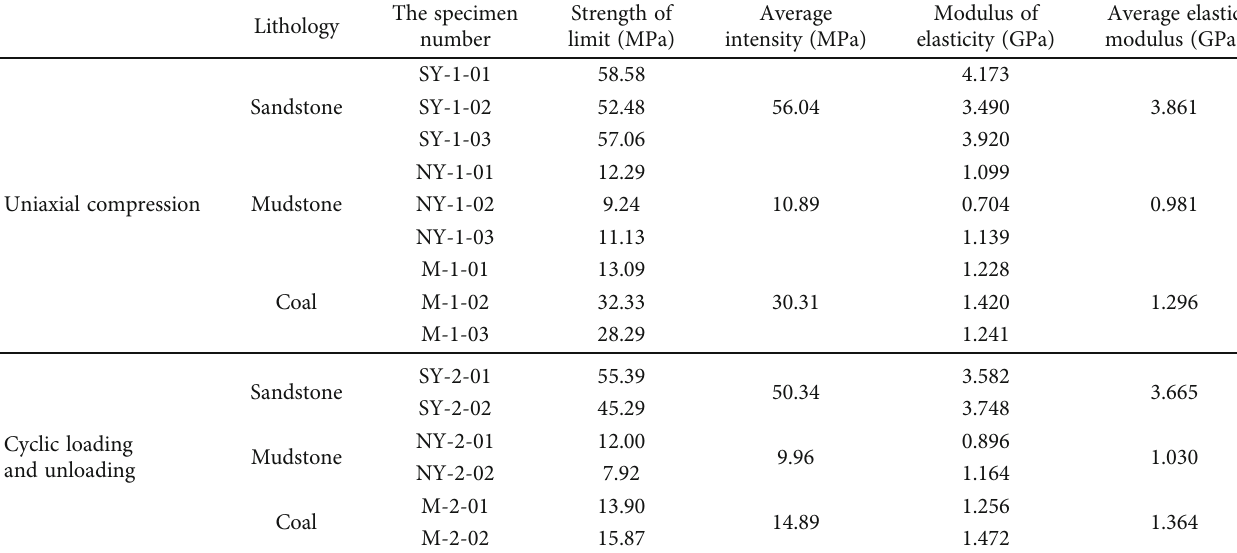
Table 2: Table of varying lithologic mechanical